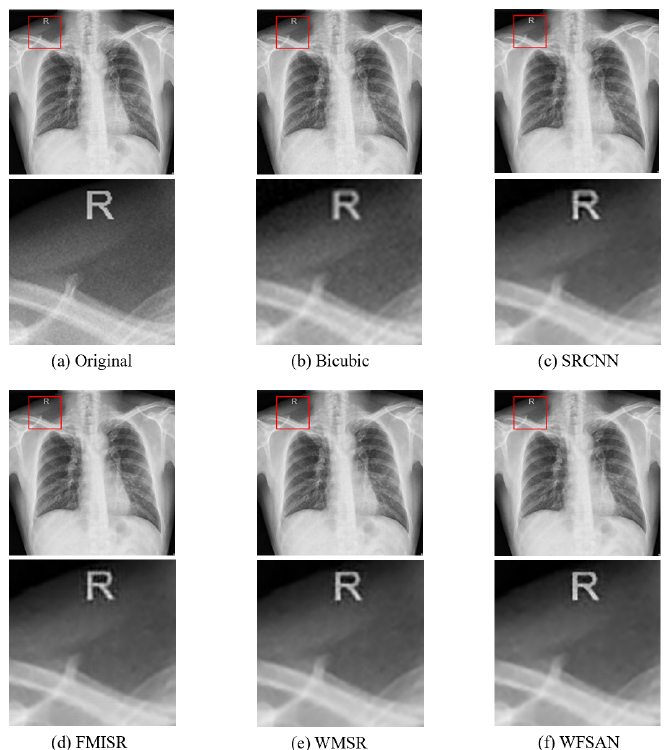
Figure 9. Visual comparison of different models in ChinaSet abnormal chest dataset, ( a ) Original(HR) image, ( b ) Bicubic, ( c ) SRCNN, ( d ) FMISR, ( e ) WMSR, ( f ) WFSAN.